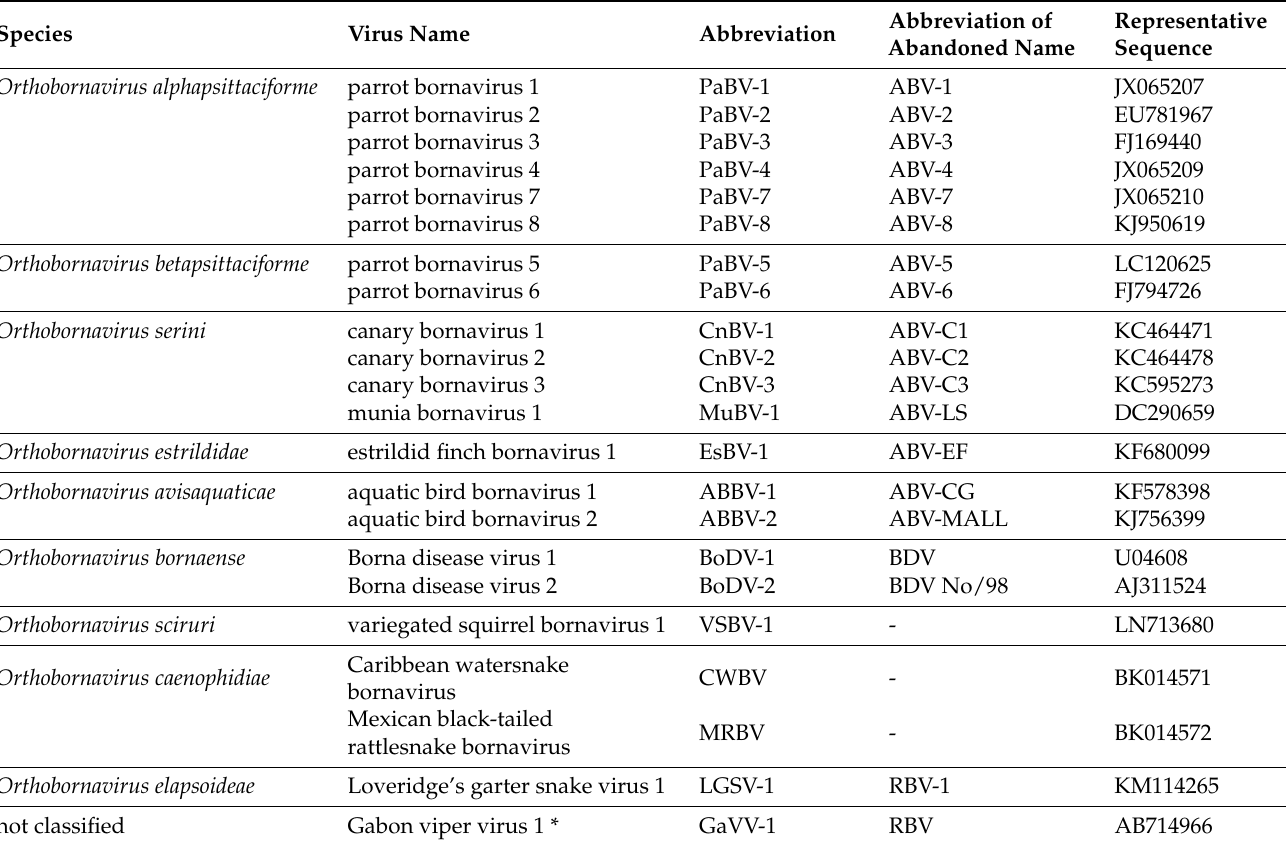
Table 1. Taxonomy of the genus Orthobornavirus